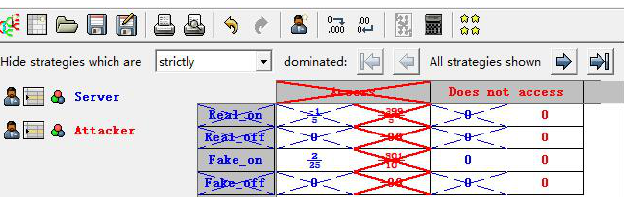
Figure 9. Dominance result when N =